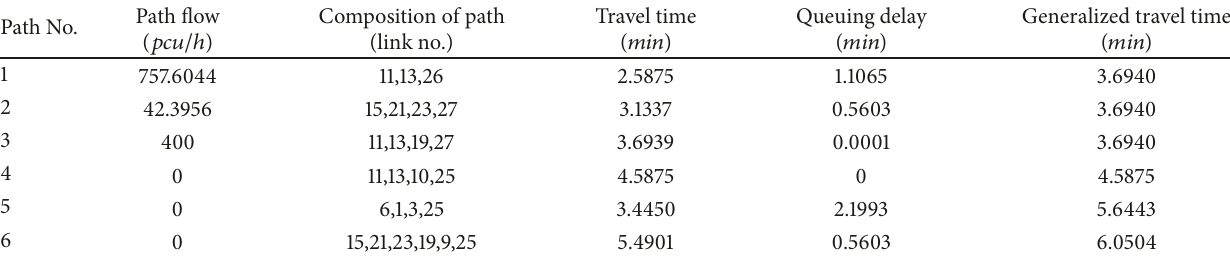
Table 5: Path details of OD pair 4-10 at equilibrium.